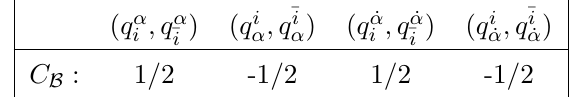
Table 2 . The hypercharge of the generators. The values of C B for the generators not appearing in the table are